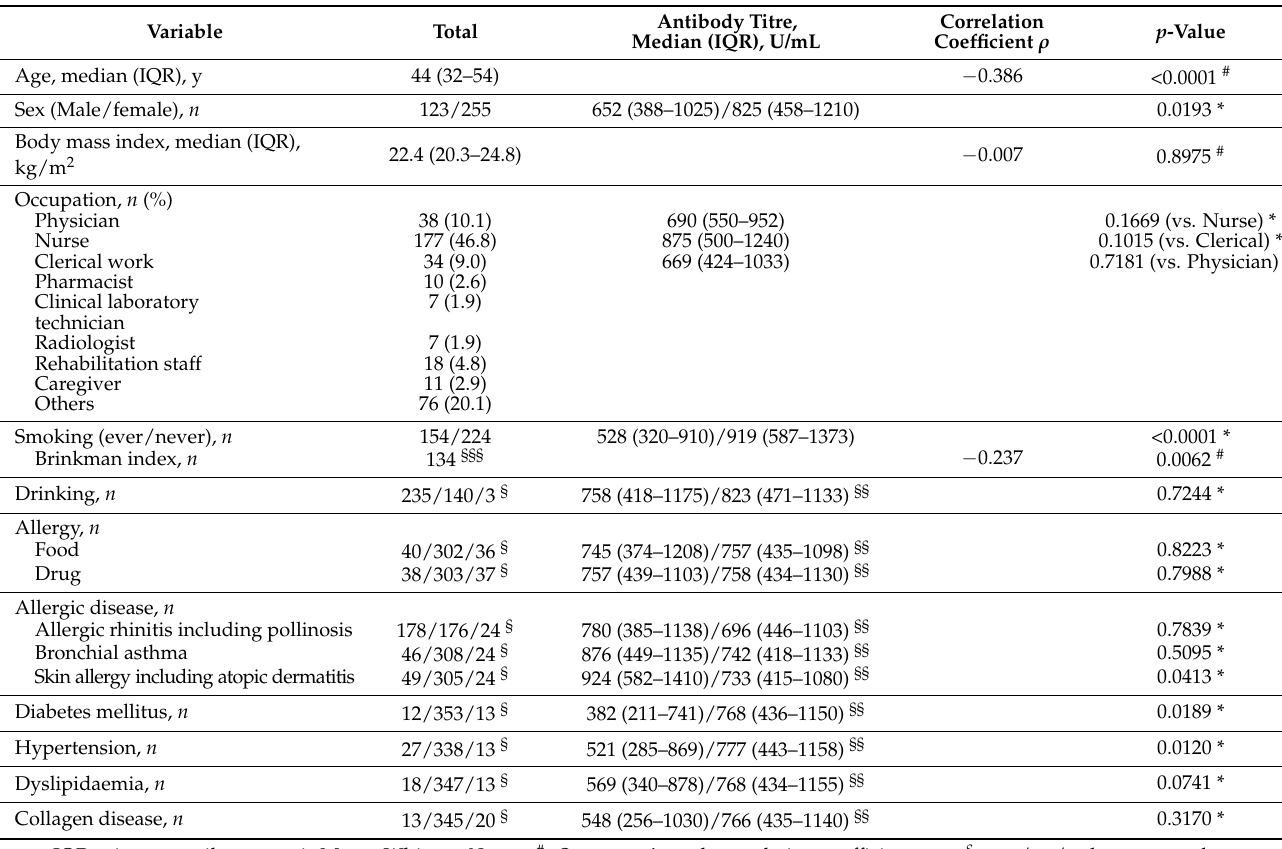
Table 1. Baseline characteristics of participants ( N =